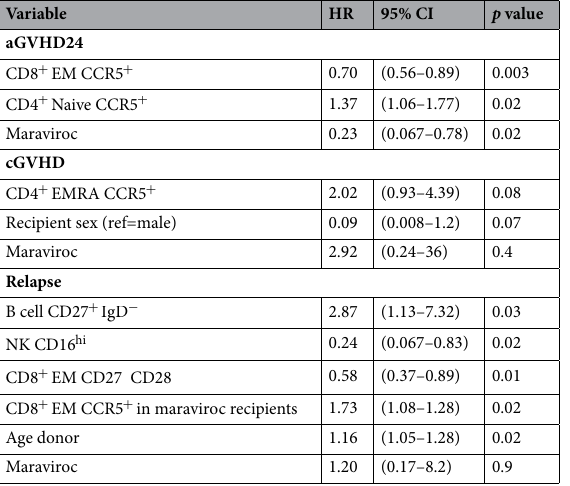
Table 2. Variable selected in final CSHMs for aGVHD24, relapse and cGVHD, with their hazard ratios (HRs), confidence intervals (CI) and p values. All models were adjusted on the treatment variable